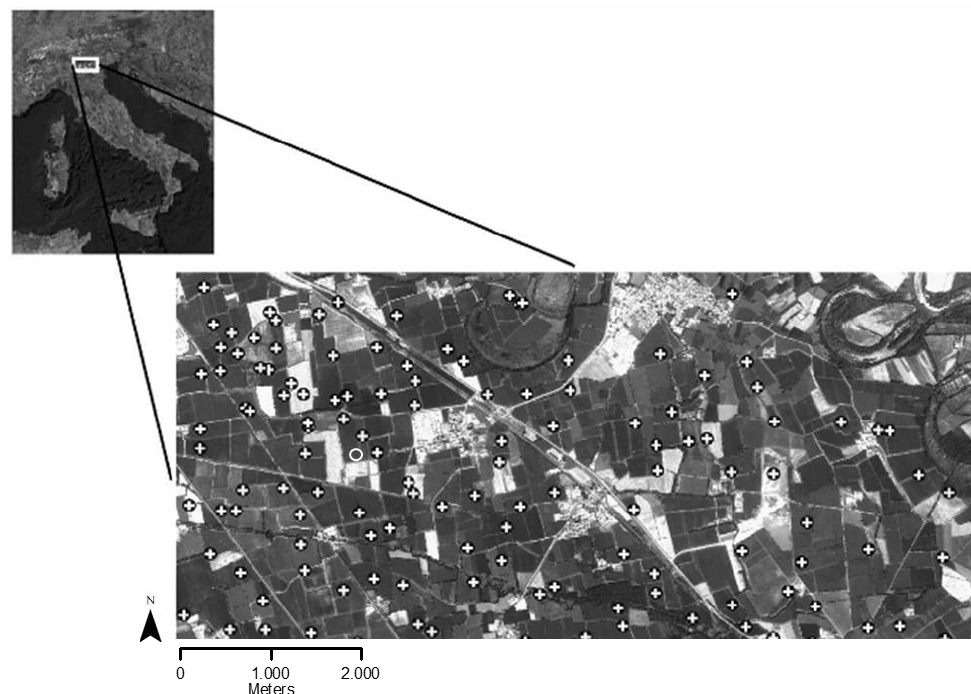
Figure 1. Study area and sampling sites (white crosses). The white circle identifies the representative soil profile. Adapted from [31] .